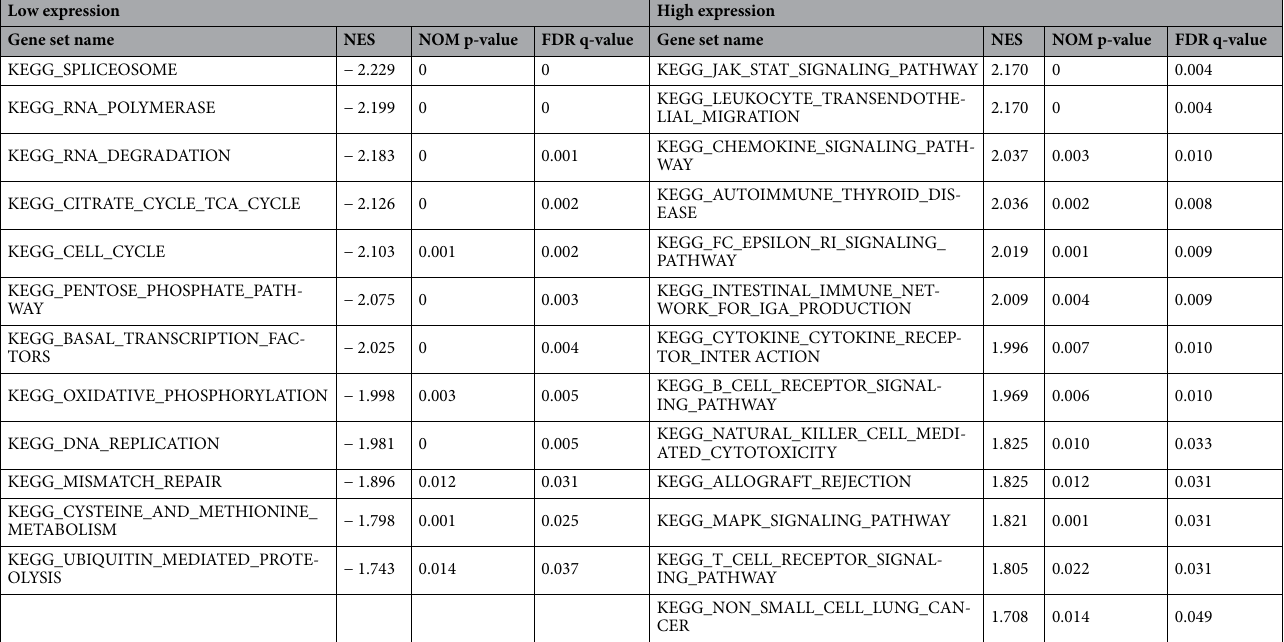
Table 3. Gene sets enriched in the low and high ADRB2 expression